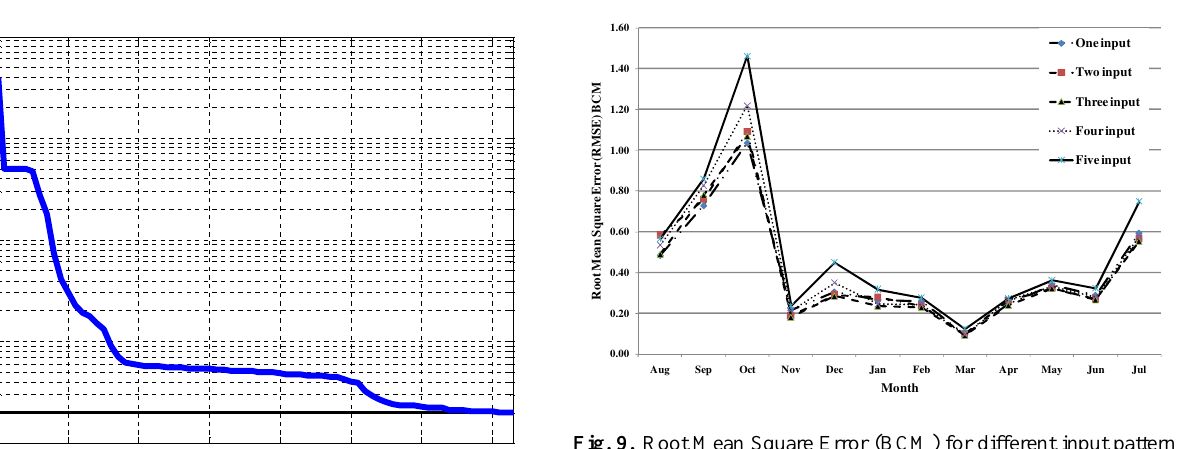
Fig. 9. Root Mean Square Error (BCM) for different input pattern during the period between 1931 and